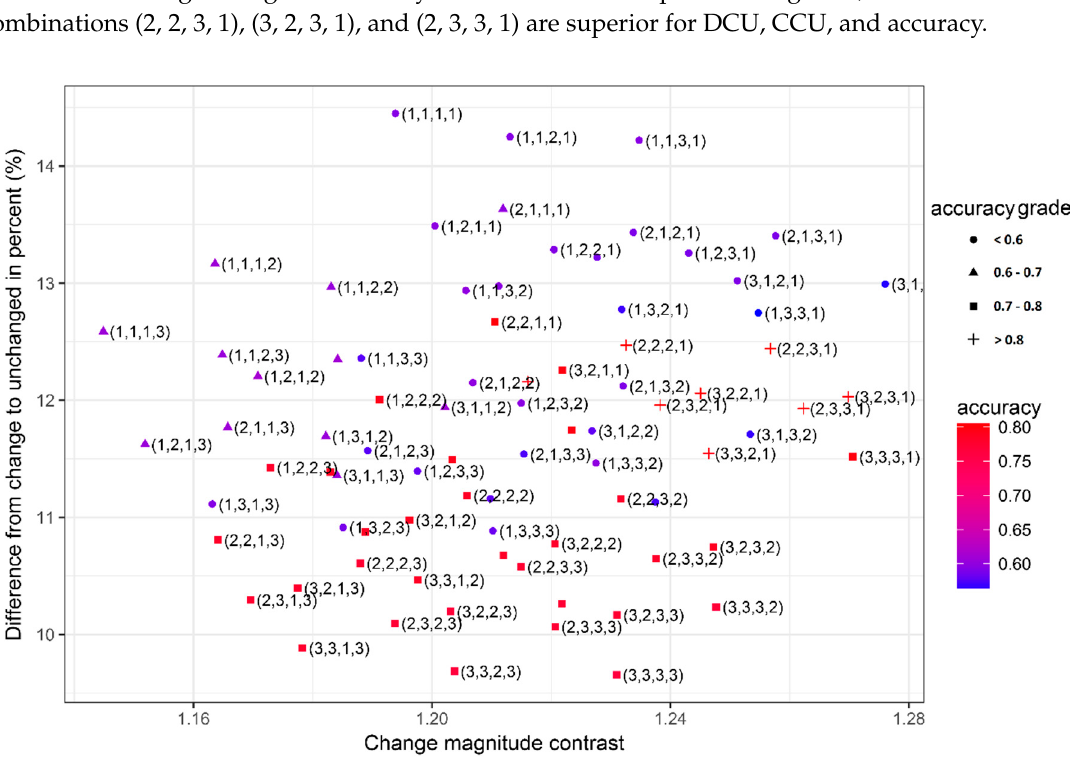
Figure 7. The overall accuracy, change magnitude contrast between the change and no-change pixels, and the difference between the change and no-change pixels in the magnitude of MSP when setting the p of phase angle cumulant (PAC), baseline cumulant (BC), relative cumulation rate (RCR), and zero-crossing rate (ZCR) as a vector ( p 1 , p 2 , p 3 , p 4 ) in the figure, calculated from the mean of the change magnitudes in 4623 ground truth points. The accuracies, grouped into to the ranges <0.60, 0.60–0.70, 0.70–0.80, and >0.80, are set as four labels in the accuracy grade bar, respectively.